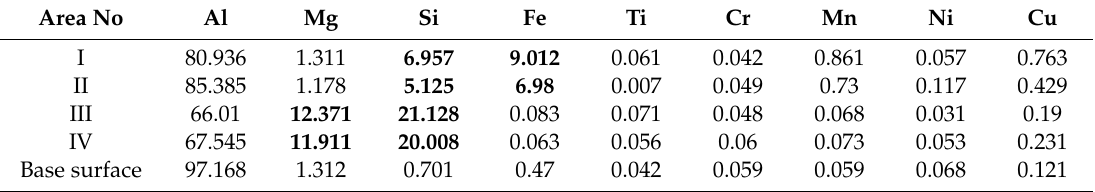
Figure 7. SEM image of Al6061 samples heated at 200 °C and held for different times: ( a ) 2 h, ( b ) 4 h, ( c ) 8 h, ( d ) 12 h. Table 1. EDX (energy-dispersive X-ray) results of the Al6061 sample in Figure 5a (Atomic %). Area